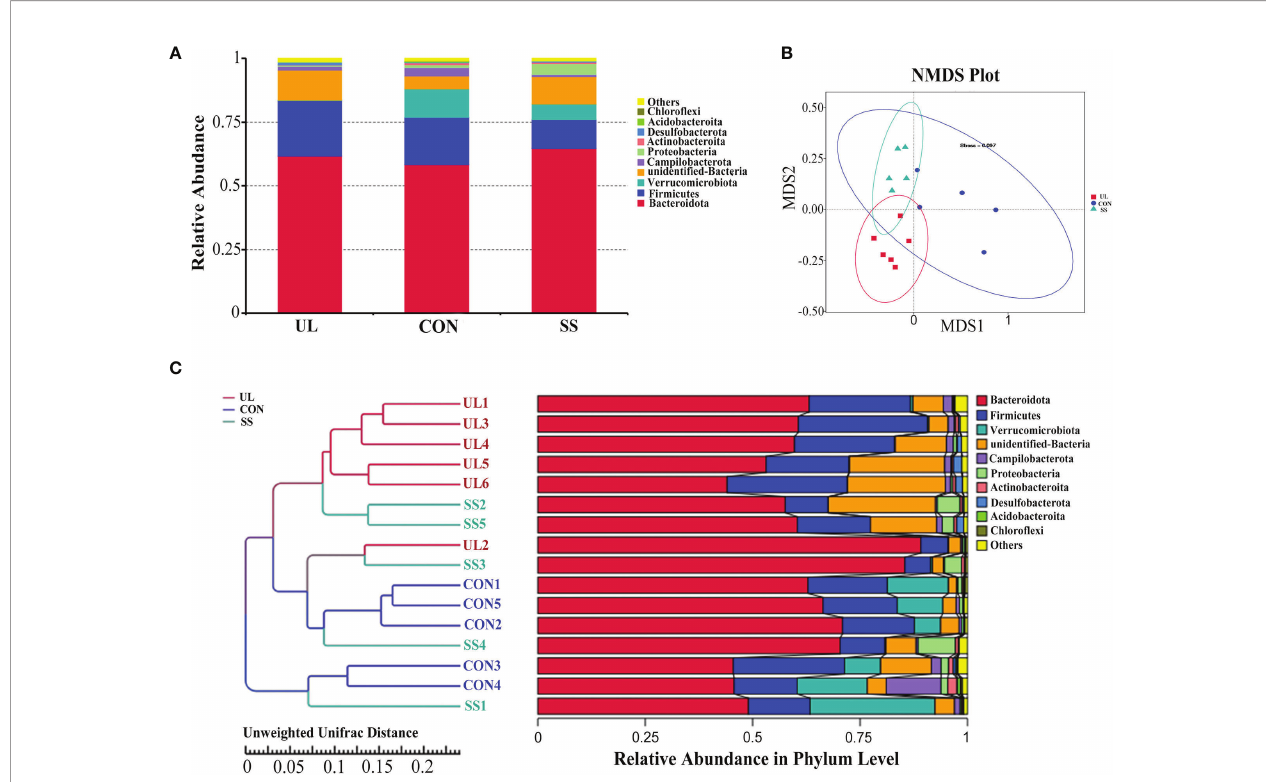
FIGURE 2 | Unilateral labyrinthectomy changes the composition of the gut microbiome. (UL: n = 6, CON: n = 5, SS: n = 5). Composition and relative abundance of bacterial phyla in the three groups (A) . Beta diversity was measured by NMDS analysis. The groups showed signi fi cant differences in similarity tested by ANOSIM (UL versus SS: R = 0.4293, p-value = 0.004; CON versus UL: R = 0.9520, p-value = 0.002; CON versus SS: R = 0.4280, p-value = 0.007) (B) . Composition of each sample at the phylum level with hierarchical clustering based on Unweighted Unifrac Distance of OTU pro fi les (C) . CON, control group; UL, unilateral labyrinthectomy group; SS, sham surgery